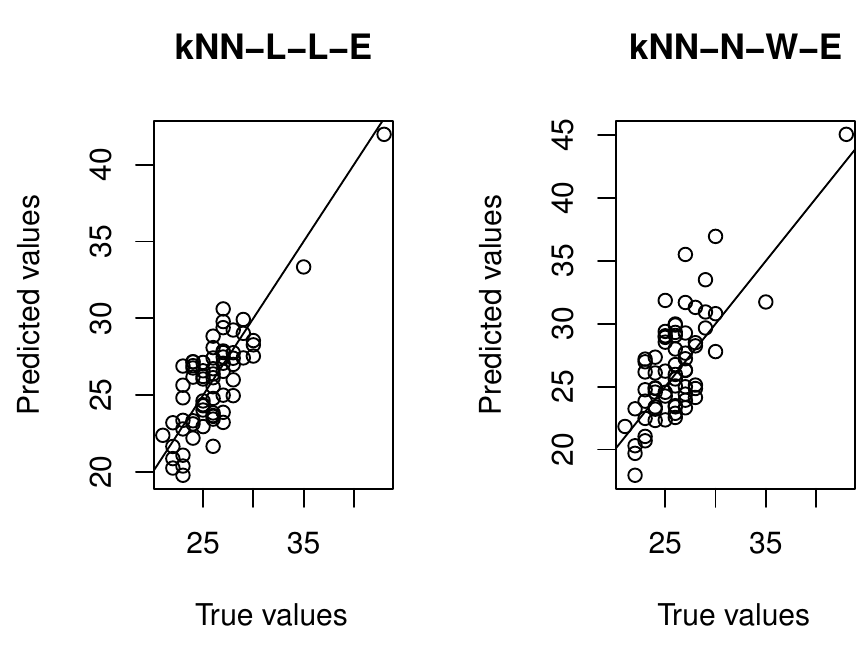
Figure 4. The prediction